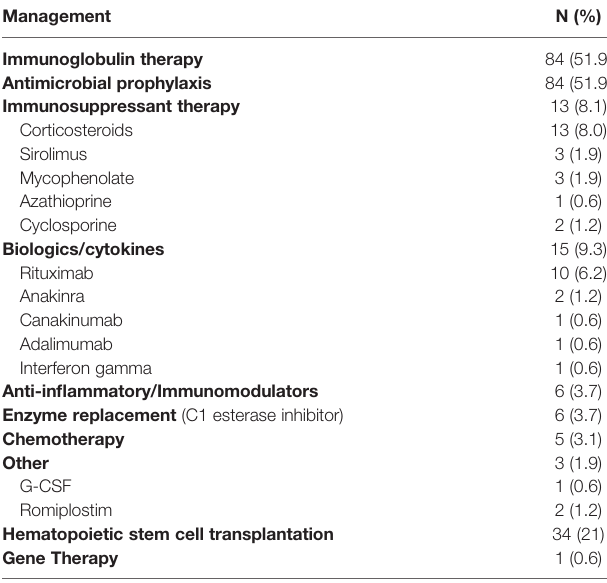
TABLE 5 | Frequency of therapies used in 162 UAE patients with